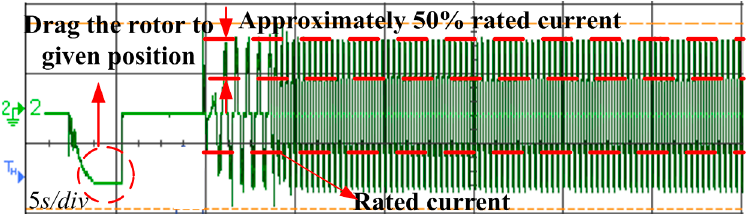
Figure 13. Operation current of PMSM by general drive method.